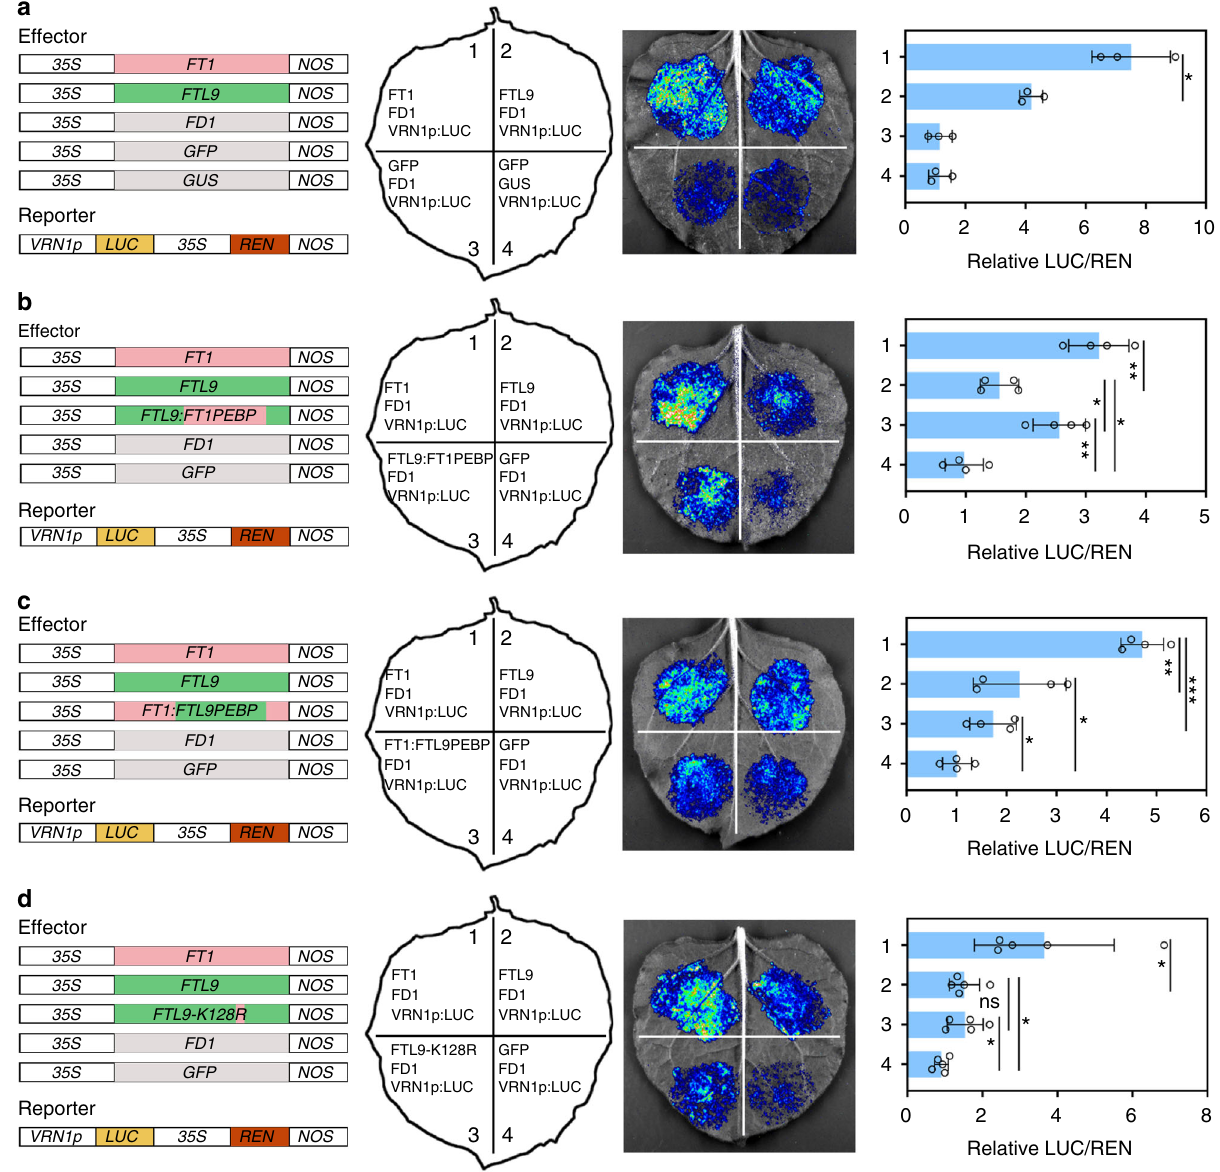
Fig. 3 FTL9-FAC has a weak fl owering inductivity in B. distachyon . a The fl owering inductive ef fi ciency of FTL9-FAC is lower than that of FT1-FAC. Error bars indicate s.d. from different injected leaves. b FAC activity by FTL9 can be enhanced when the FTL9 PEBP domain is changed to that of FT1. PEBP domain of FTL9 is arti fi cially swapped to that of FT1 and introduced to A.tumefaciens with FD1 and 3 kb VRN1 promoter-mediated LUC constructs, and co-in fi ltrated into N. benthamiana leaves. Error bars indicate s.d. c FAC activity by FT1 can be compromised when the FT1 PEBP domain is changed to that of FTL9. PEBP domain of FT1 is arti fi cially swapped to that of FTL9 and introduced to A.tumefaciens with FD1 and 3 kb VRN1 promoter-mediated LUC constructs, and co- in fi ltrated into N. benthamiana leaves. Error bars indicate s.d. d Lysine at residue 128 of FTL9 is not responsible for the speci fi c fl owering ability of FTL9 in B. distachyon . Error bars indicate SD. (Student ’ s t test, * P < 0.05, ** P < 0.01, *** P < 0.001) Left: Different combinations of effectors and the reporter